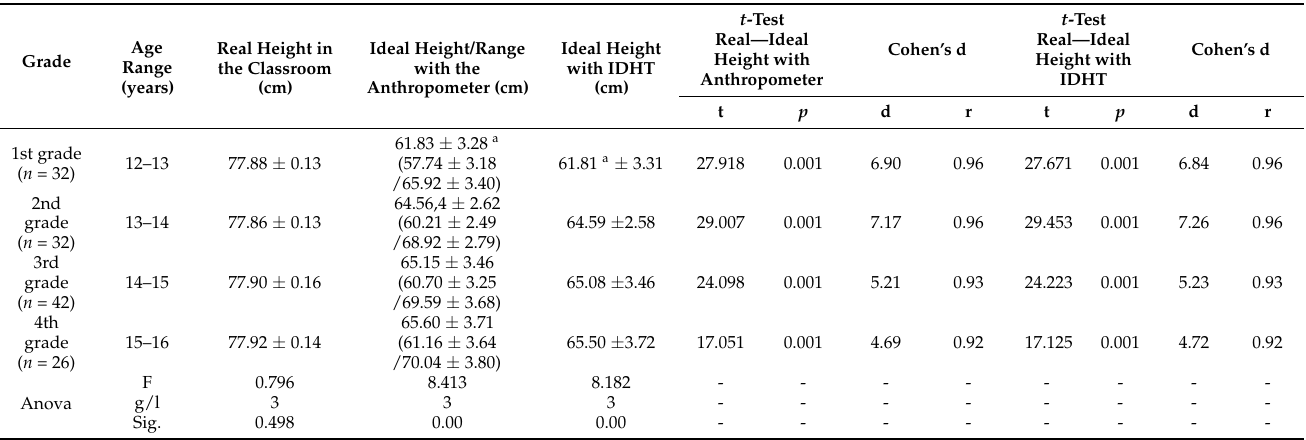
Table 3. Comparison of desks between grades (Anova) of the ideal height/range with the anthro- pometer and the ideal height using IDHT. Comparison by grade of the real height with the ideal height with the anthropometer and the real height with the ideal height using IDHT ( t -test for related